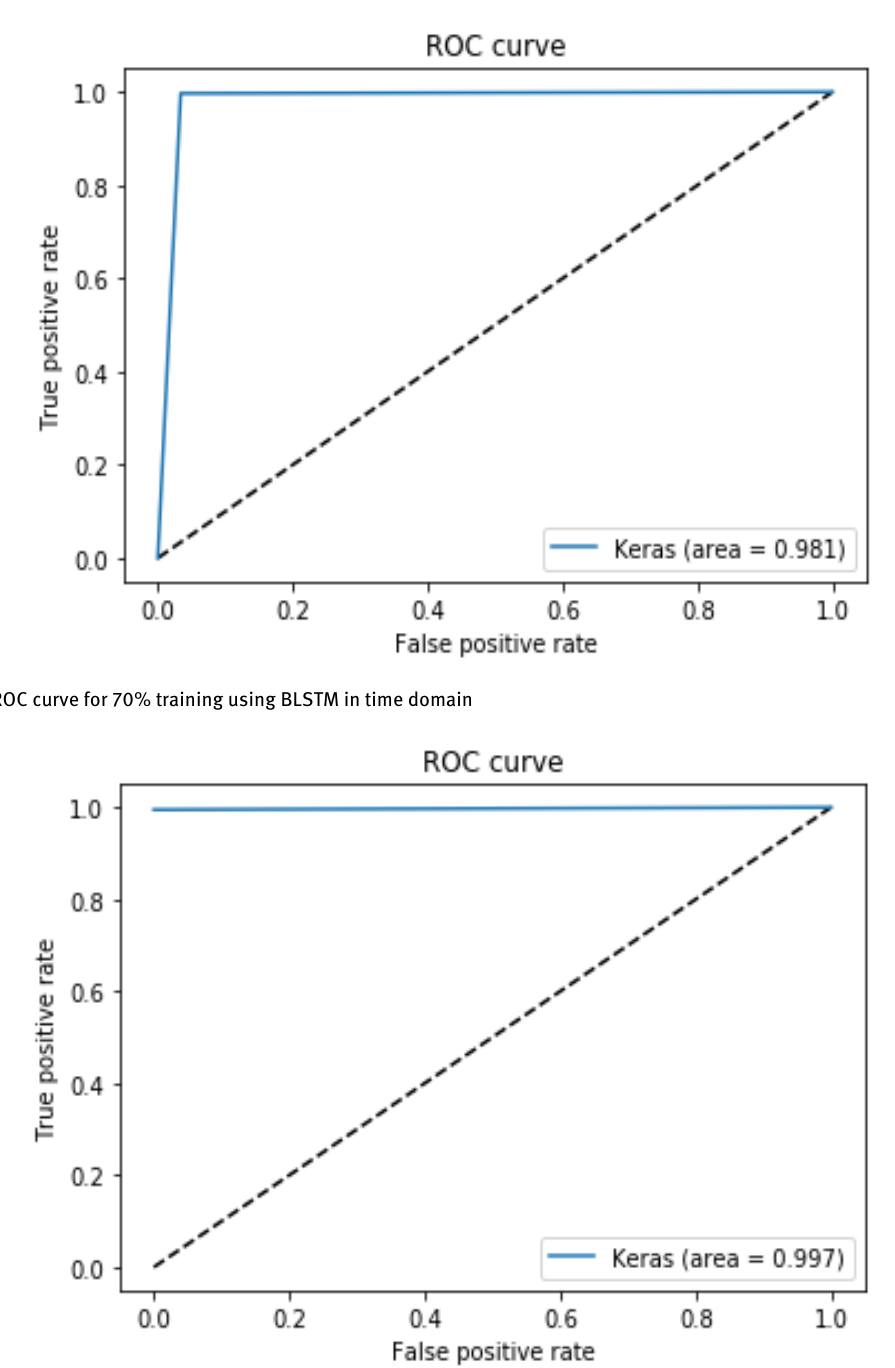
gearbox diagnosis and compared the performance of proposed models with these classical machine learning models. Hence, Statistical features such as min, max, mean, standard deviation, variance, autocorrelation, quantile, skewness and entropy are extracted from the raw vibration data (time series vibration data) of bad and good conditioned samples of aircraft gearbox system. The classical machine learning classifiers are used separately for the purpose of classification of samples of aircraft gearbox vibration data into good or bad. We made a same experimental setup as in the proposed models. Comparison of performance of the